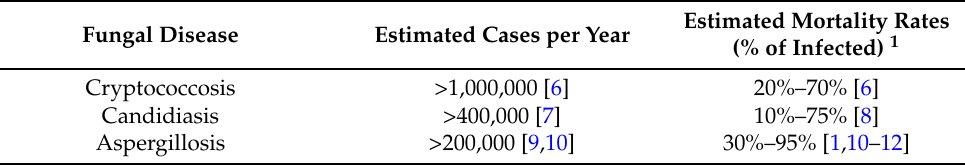
Table 1. Estimated yearly incidences of invasive fungal